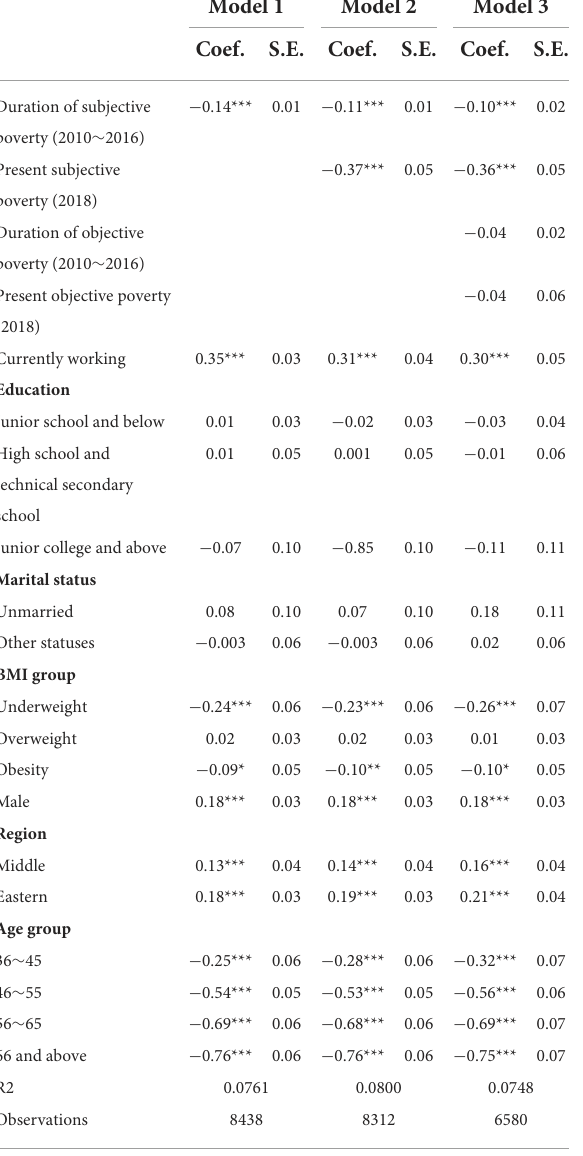
TABLE 4 Duration of subjective poverty and SRH in the rural sample. TABLE 5 Different durations of subjective poverty and